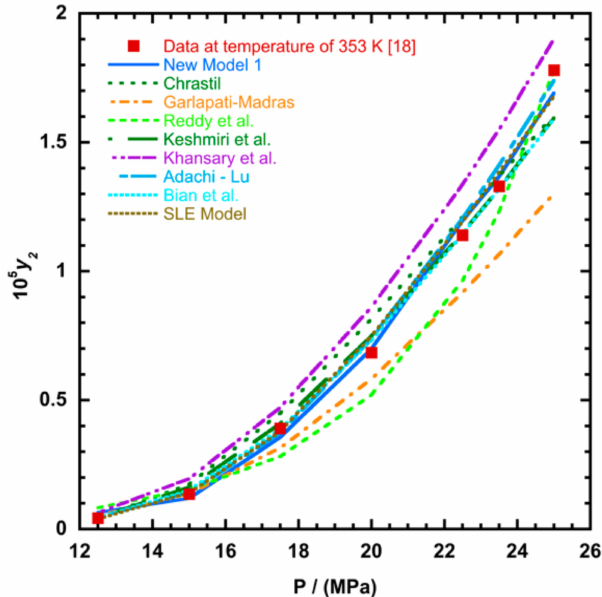
Figure 5. Plot of mole fraction solubility of Red 15 (1-amino-4-hydroxyanthraquinone) against pressure (P/MPa), the solid line presents the new model 1 (Equation